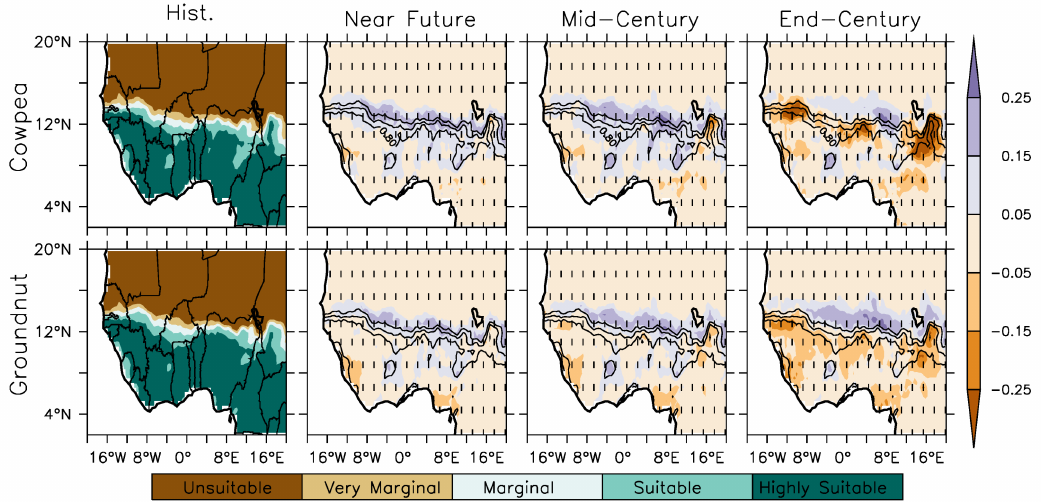
Figure 4. Same as Figure 3 but for the legume crops, cowpea and